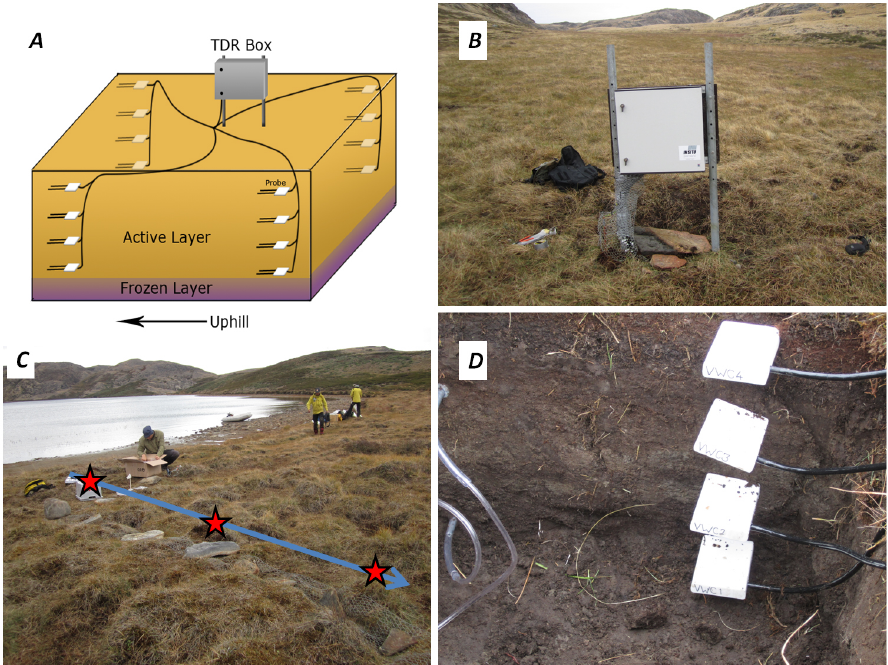
Figure 3. Schematic figure (a) and photo (b) of TDR installation no.1. Panel (c) shows a photo of the TDR transect no. 3, and a pit with four TDR sensors along a profile is shown in (d)